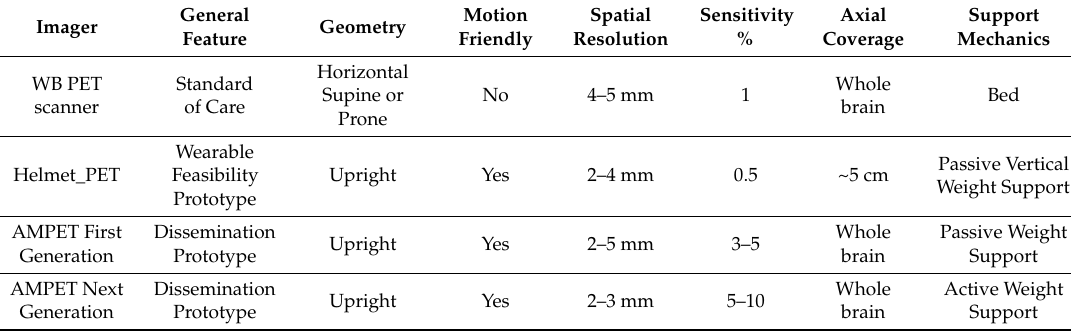
Table 1. Comparison between standard PET scanner and upright